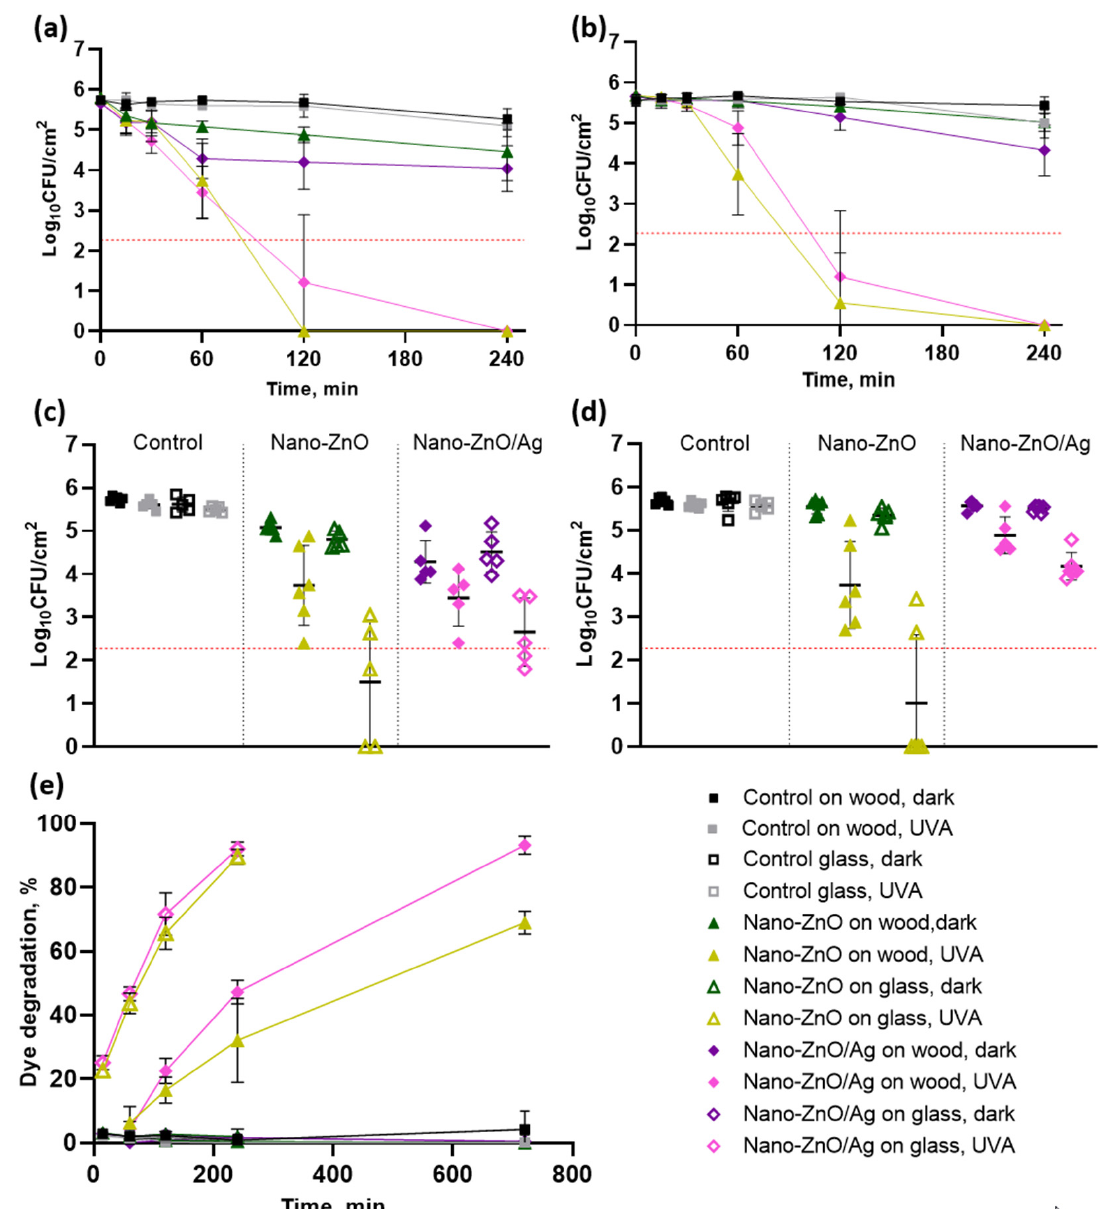
Figure 4. Antibacterial activity of matrix-embedded nano-coatings (on wood) ( a , b ) towards E. coli ( a ) and S. aureus ( b ); comparison of antibacterial effect of matrix-embedded nano-coatings (on wood) during 1 h and bare NPs on glass surfaces during 15 min ( c , d ) towards E. coli ( c ) and S. aureus ( d ). Photocatalytic dye degradation ( e ) is shown to illustrate differences in photocatalytic efficiency of the studied surfaces. Mean value from 3 experiments ±SD is presented. Red dotted line denotes the practical limit of quantification with 3 colonies counted in undiluted samples.